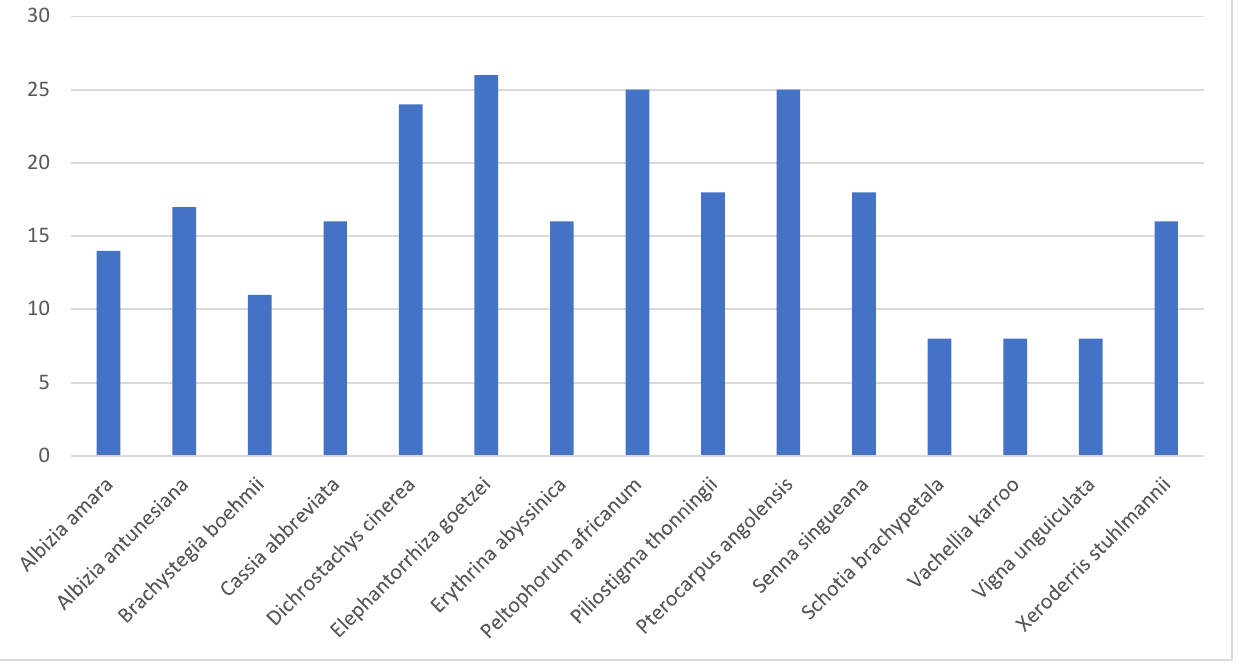
Table 3. Phytochemistry and pharmacological properties of Fabaceae species used as traditional medicines in